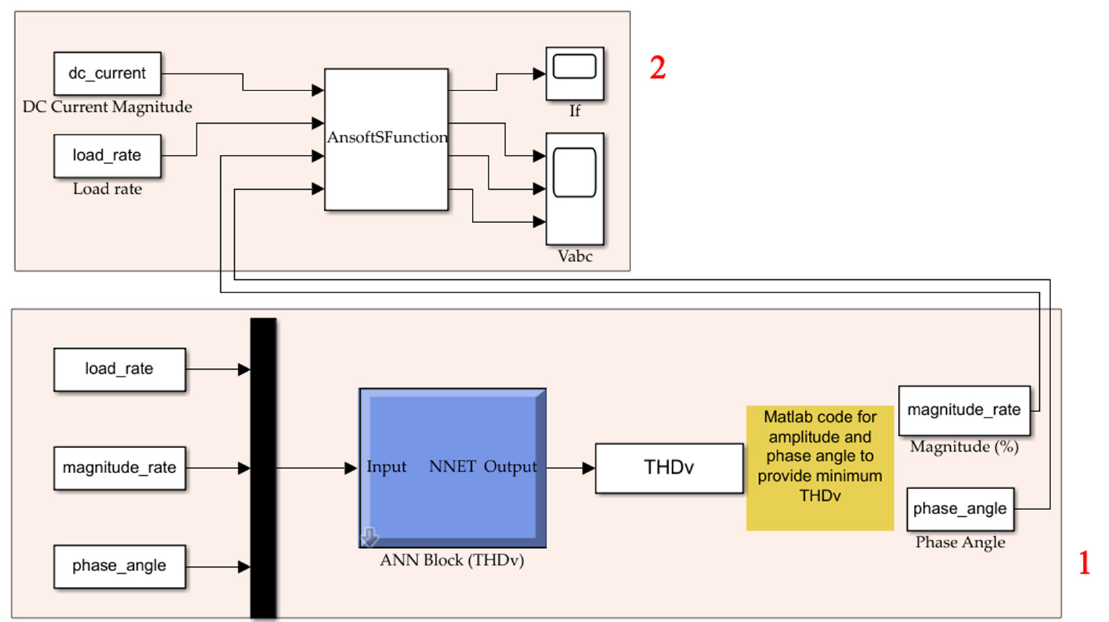
Figure 12. Implementation blocks of the proposed model in MATLAB/Simulink environment.